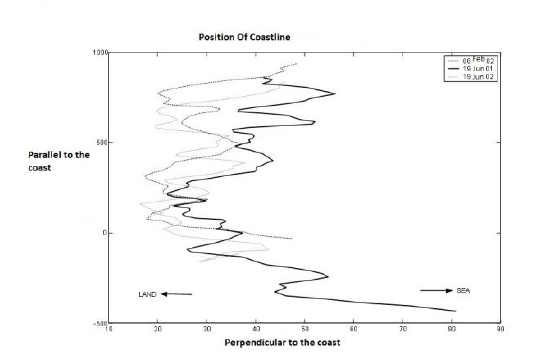
Figure 3: The measured shoreline between June 2001 and June 2002